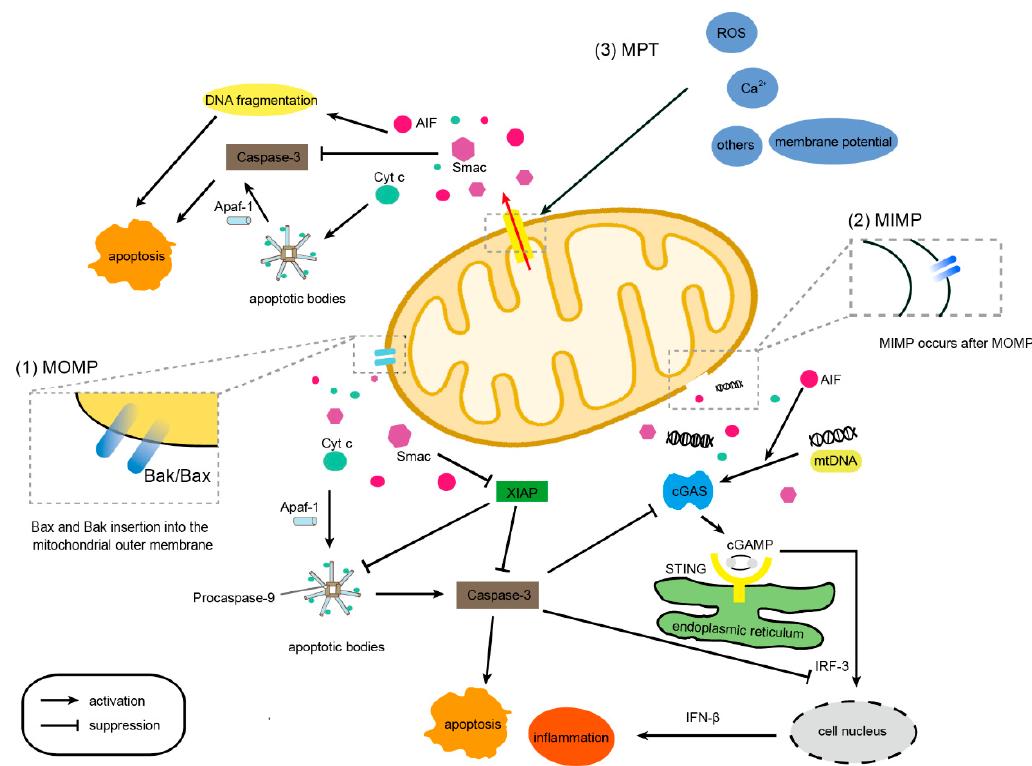
Figure 1. Main apoptosis mechanisms induced by MOMP, MIMP, and MPT. (1) Bak/Bax aggregates and forms pores in the OMM. Cyt c , AIF, Smac, and other molecules leak from the pores. After a series of reactions, Cyt c , Apaf-1, and procaspase-9 assemble into apoptotic bodies and subsequently activate caspase-3. Caspase-3 inhibits inflammation and induces apoptosis. The released Smac can inhibit the antiapoptotic effect of XIAP. (2) MIMP occurs after MOMP. Under pathological conditions or in the absence of caspases, the cGAS-STING signaling pathway can be activated by mitochondrial DNA (mtDNA) and AIF to release IFN- β and other inflammatory factors, thus triggering inflammation. (3) Changes in intracellular ROS, Ca 2+ concentration, or mitochondrial membrane potential depolarization can induce MPTP to remain open, leading to changes in both outer and inner mitochondrial membrane permeability. During MPT, Cyt c , AIF, Smac, and other molecules are released, inducing apoptosis in a caspase-3-dependent